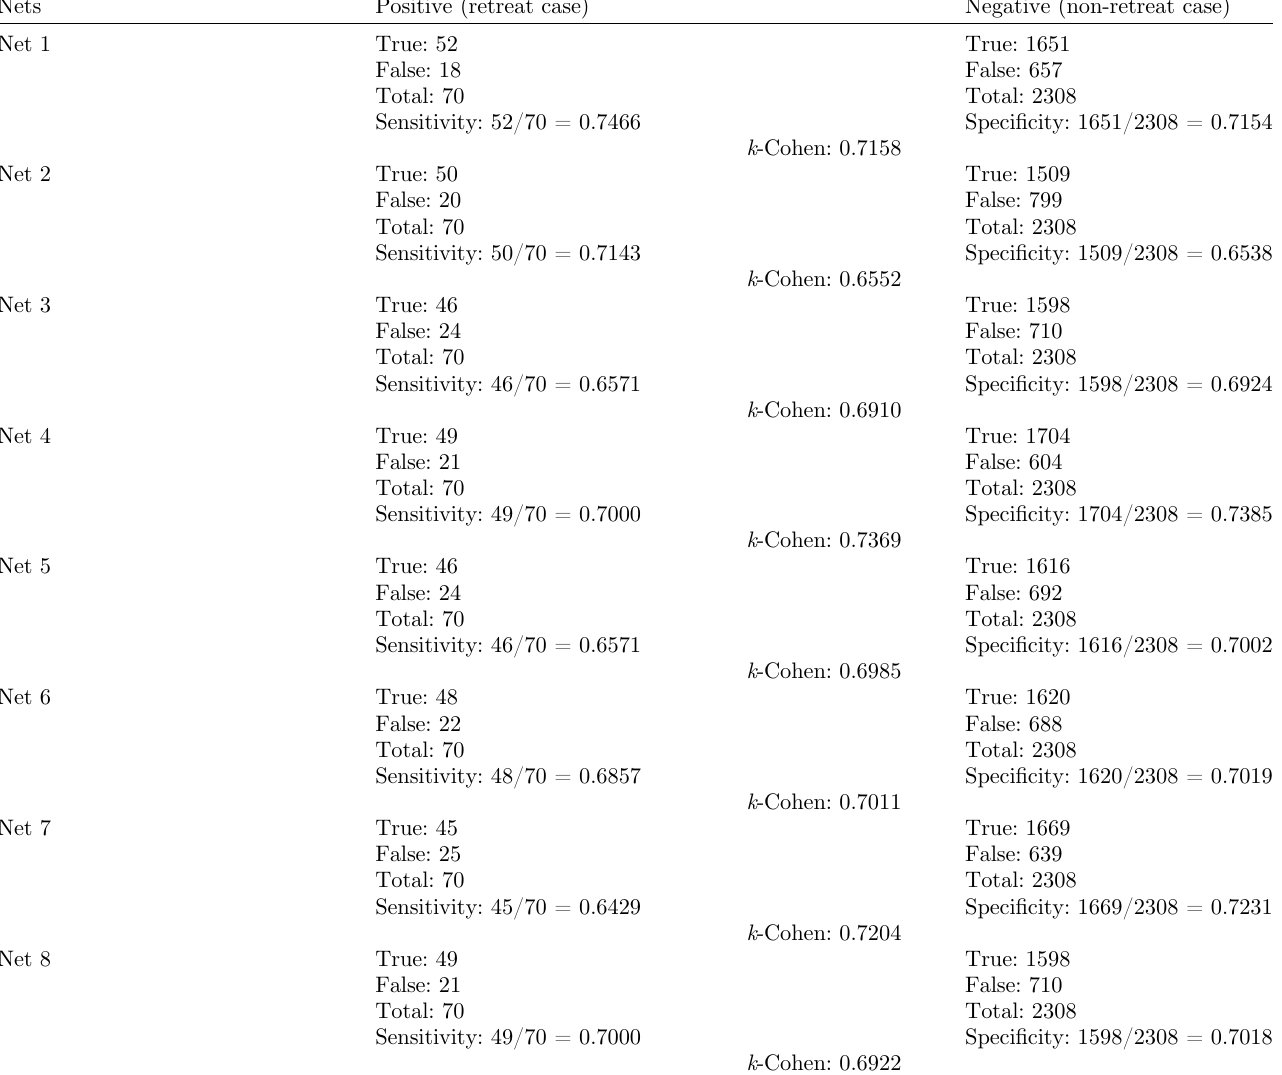
Table 5. Measuring sensitivity, speci fi city, and Cohen ’ s Kappa statistic ( k -Cohen).